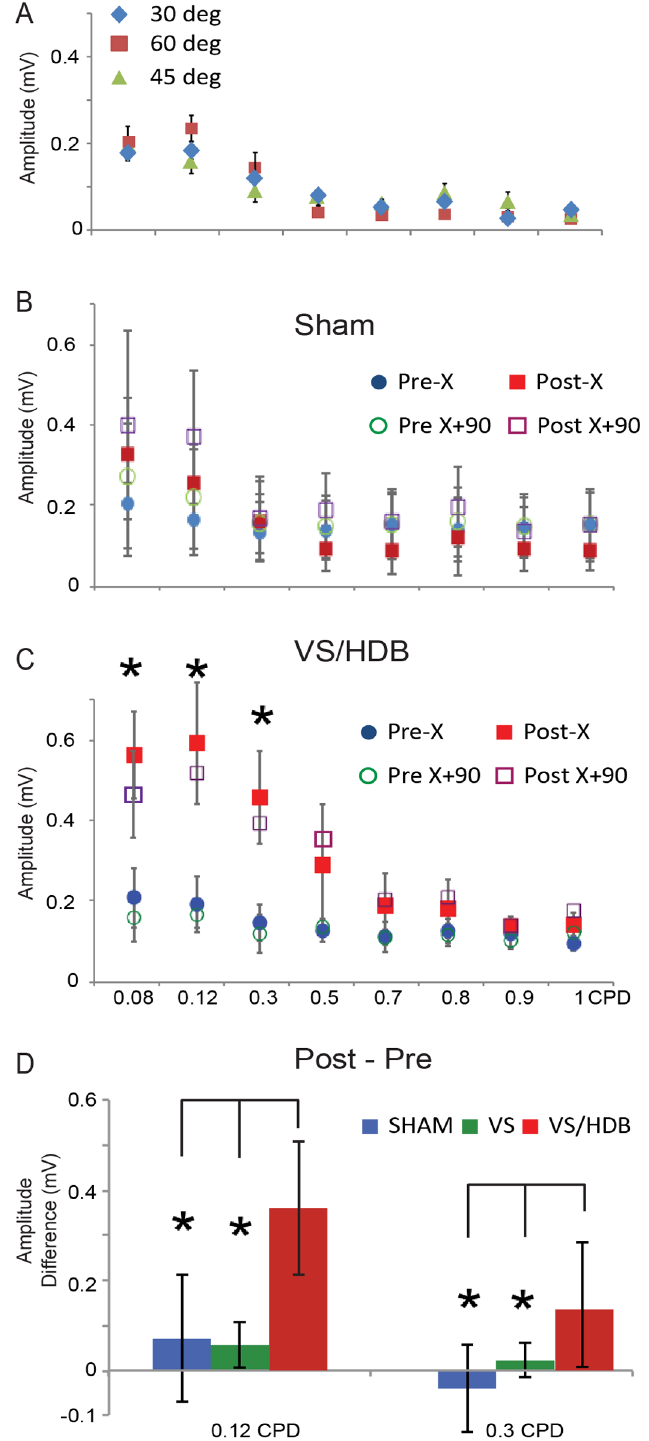
Fig 2. Effects of repetitive Visual/cholinergic stimulation (VS/HDB) on VEP amplitudes. A) Basal VEPs in response to 30°, 45° and 60° stimuli orientation recorded prior to any experimental procedure. There were no differences in VEP amplitudes between the orientations, which were subsequently pooled into the X° and X+90° groups. B) VEP amplitudes from the sham (grey screen/no HDB stimulation) animals in response to different orientations and spatial frequencies. There were no significant differences between the pre-